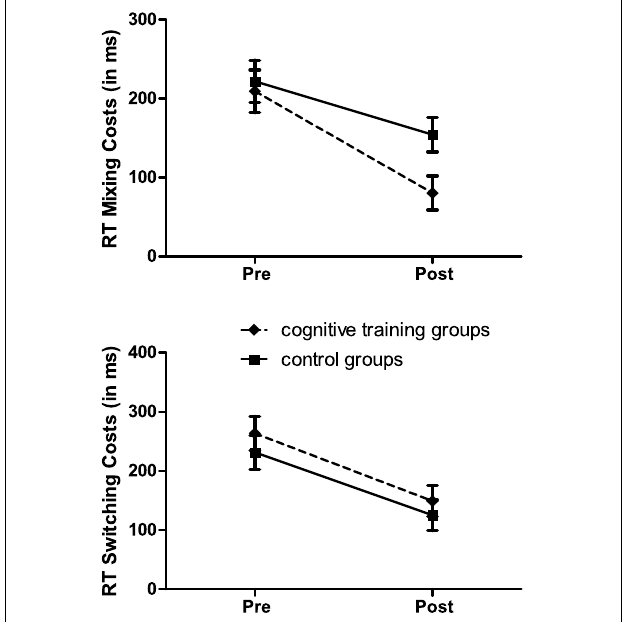
FIGURE 2 | Changes of RT mixing and switching costs (in ms ± SE) in near transfer switching task from pre- to posttraining assessments in the cognitive training groups and the control